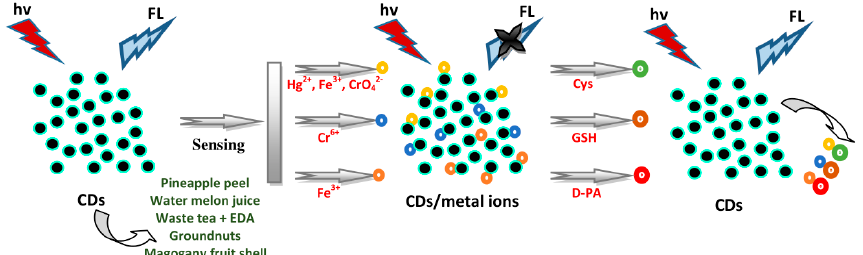
Figure 6. Illustration of the use of plant part-derived CDs for the detection of amino acids and thiols. “Turn-on” FL intensity was shown after the interaction of Cys, GSH, and D-PA with CD/ion systems. Abbreviations: GSH, glutathione; D-PA, D-penicillamine.